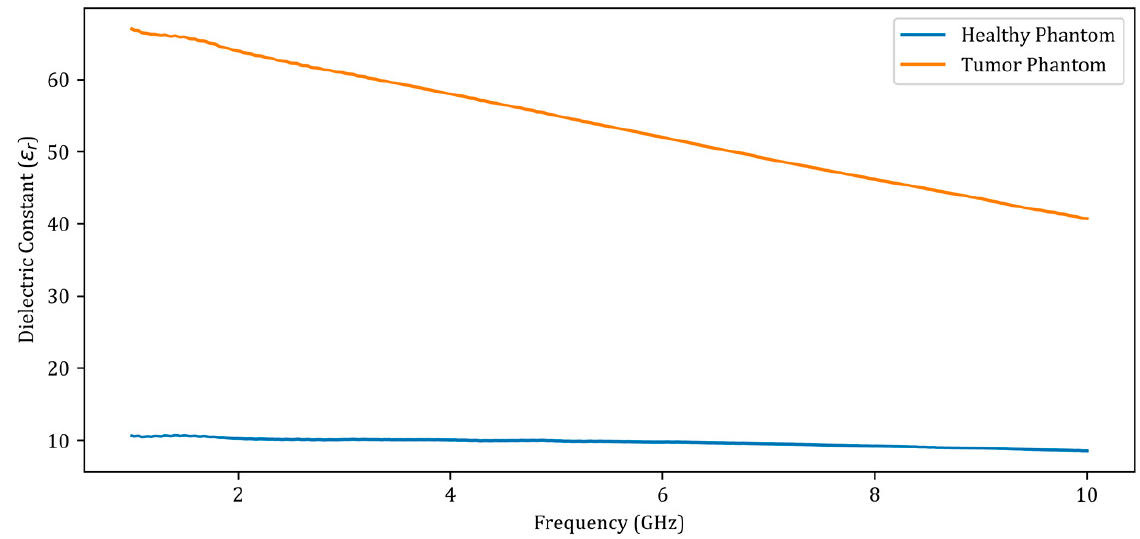
Figure 3. Dielectric constants of the fabricated phantoms between 1 GHz and 10 GHz.